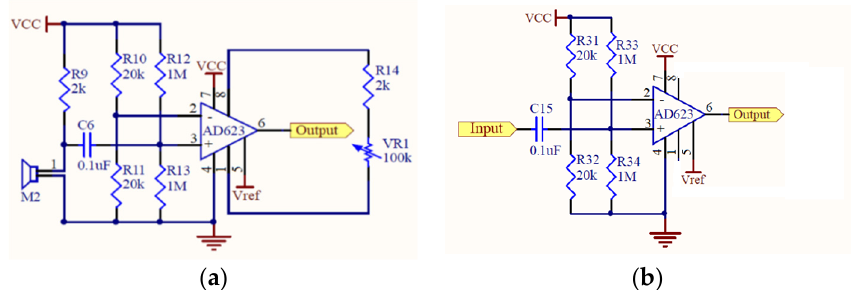
Figure 4. ( a ) First-stage amplification circuit and ( b ) second-stage amplification circuit for noise sounds.